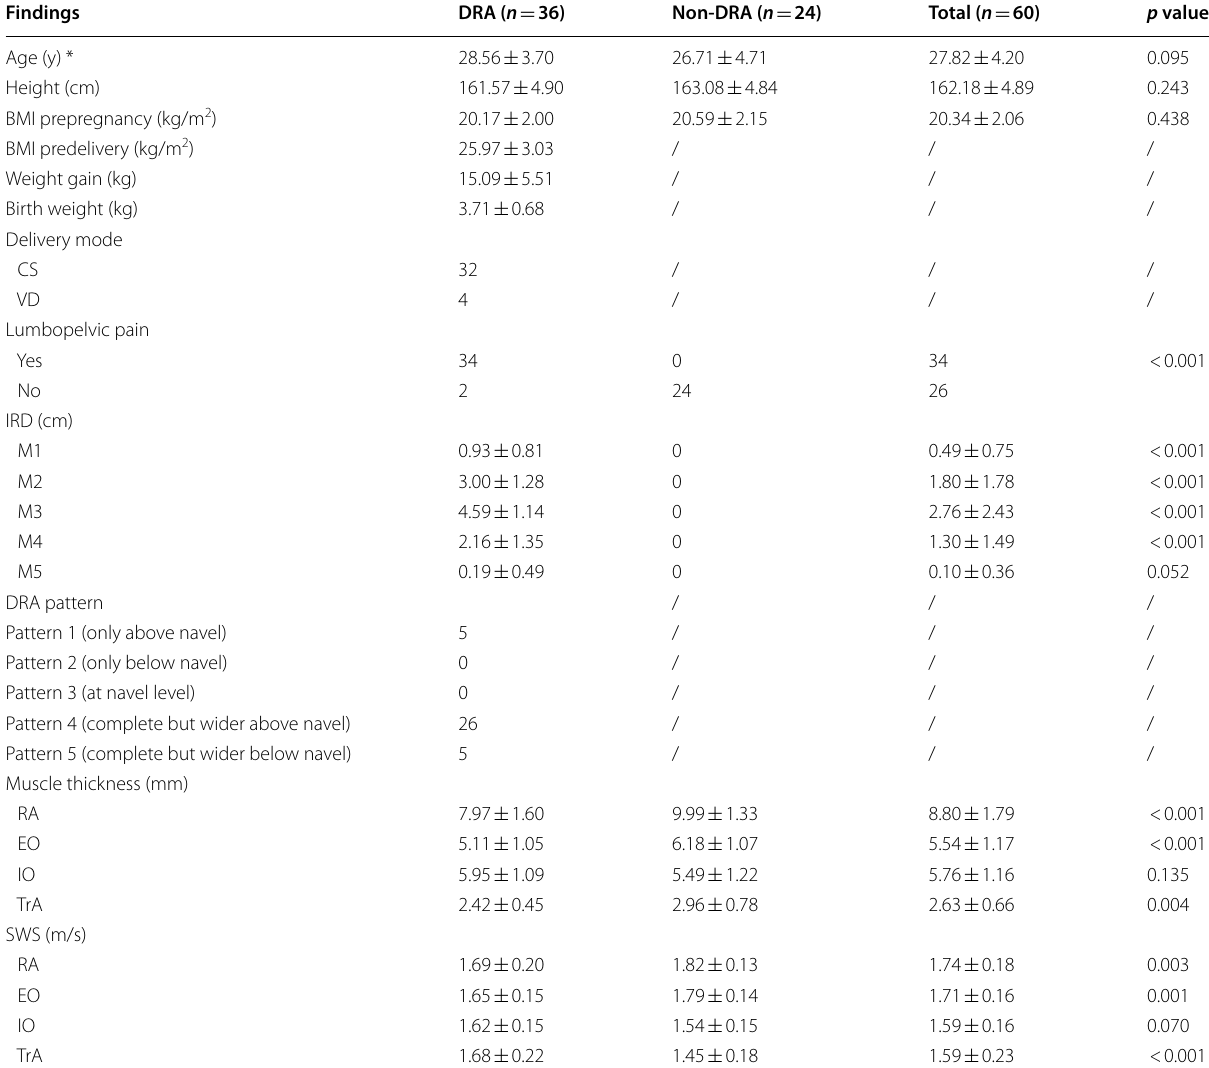
Table 2 Frequency of clinical and US features in 36 DRA patients and 24 nulliparous healthy controls